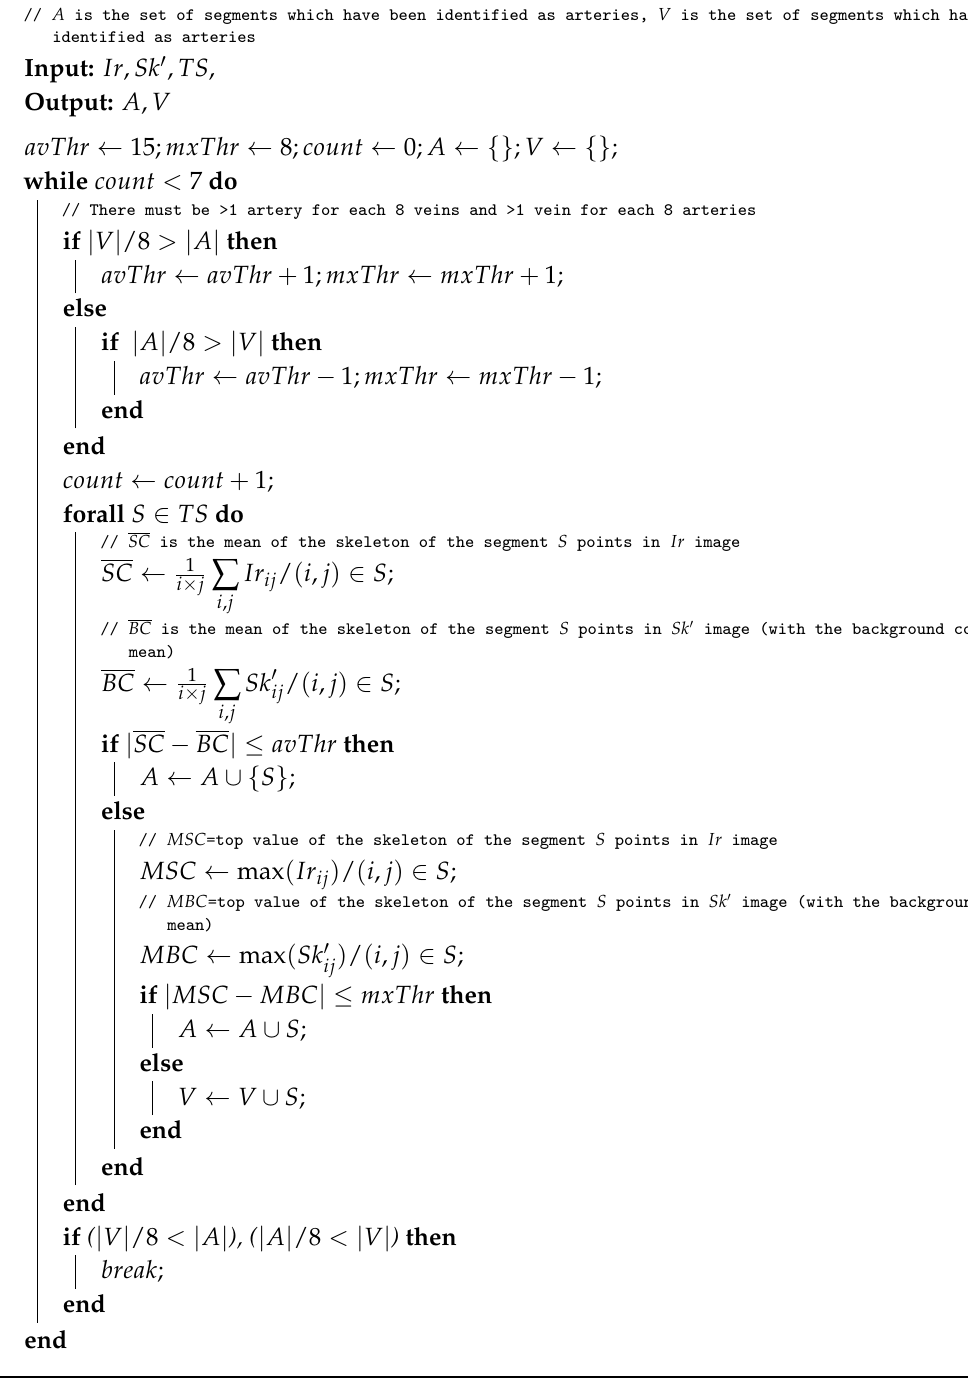
Algorithm 6: Vessels and segments